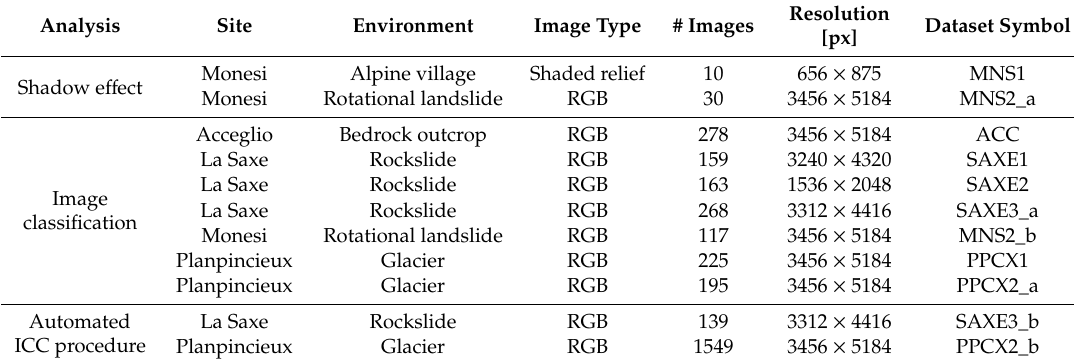
Table 1. Datasets adopted in the current study. The first column lists the type of analysis employed using the various datasets. Also presented is the site where images were acquired for each dataset, the type of environment and image, the number of elements, the image resolution and the symbol attributed to the